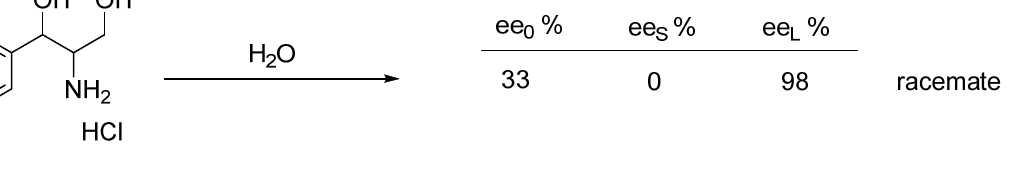
Figure 20. The higher the enantiomeric enrichment, the significantly purer fraction remains in solution ( FTHQ forms a conglomerate from melt, while its hydrochloride forms a racemate). The intermediate of Chloramphenicol also forms a racemate as a hydrochloride mon- ohidrate ( AD · HCl · H 2 O ) [29] recrystallized from water (Figure 21).